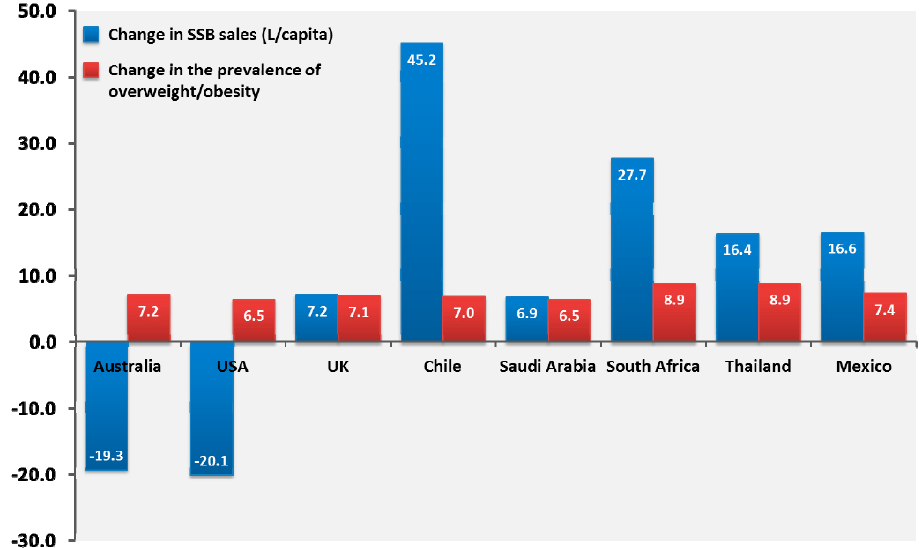
Figure 2. 2002–2014 changes in sugar-sweetened beverage sales presented in litres per capita, and 2002–2014 changes in the percentage of the population who is either overweight or obese (body mass index ≥ 25 kg/m 2 ) in selected countries from various regions of the world. Sugar-sweetened beverages were defined as the sum of on trade (bars, cafés, restaurants, etc.) and off trade (grocery stores, independent retailers, etc.) sales in any sugar-sweetened sodas (regular cola carbonates, lemonade/lime carbonates, ginger ale, tonic water, and orange carbonates), juice drinks (up to 24% juice), and nectars (25–99% juice), as well as sports drinks and energy drinks. Low-calorie cola carbonates and 100% fruit juices were not included. Data on body mass index changes were obtained from the World Health Organisation website.